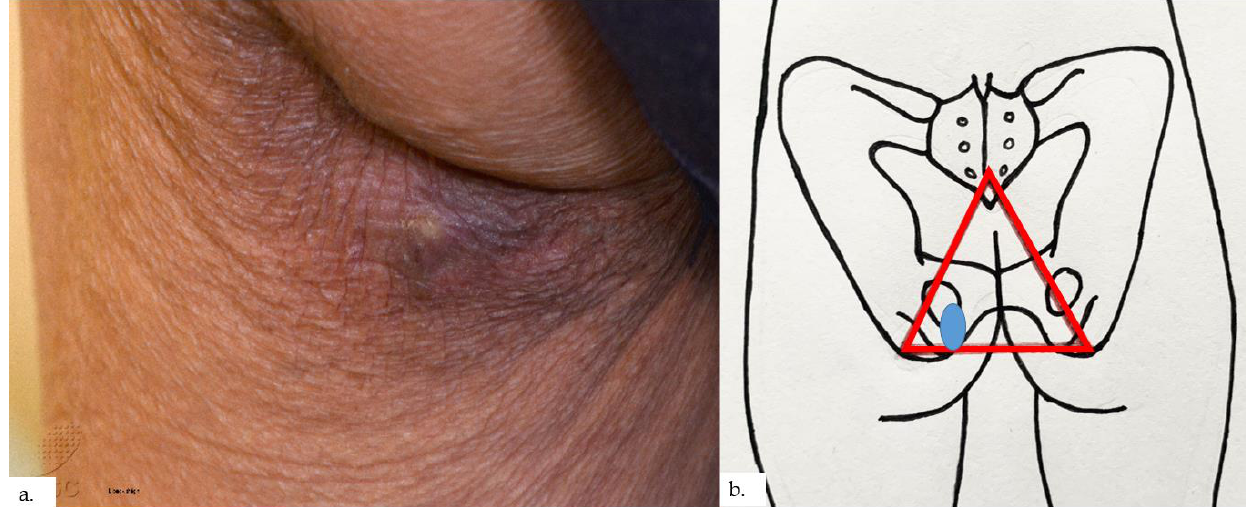
Figure 7. Patient 4. ( a ) There was a small tender 0.5 cm rounded dermal centered nodule over the left buttock. The surrounding skin showed hyperpigmentation and lichenification; ( b ) the nodule and surrounding lichenification were over the left gluteal fold, overlying the ischial tuberosity, at the base of the sitter’s triangle (red tr iangle).